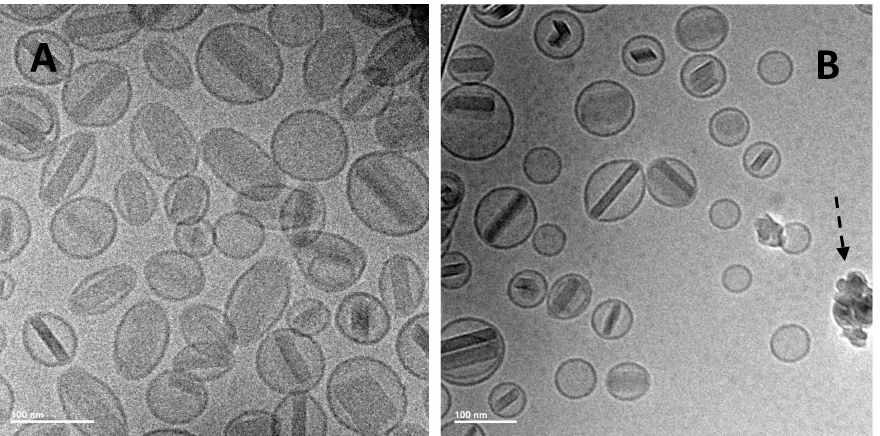
Figure 19. Cryo-TEM micrographs of 12.5 mg/mL Lipoquin, 90 mg/mL sucrose, 0.1% polysorbate 20, pH 5.3. ( A ) After freeze-thaw; ( B ) after freeze-thawing and nebulization. The scale bar in the bottom left-hand corner is 100 nm for both images. The dashed arrow in ( B ) shows ice artifacts introduced during sample preparation. Reprinted with permission from